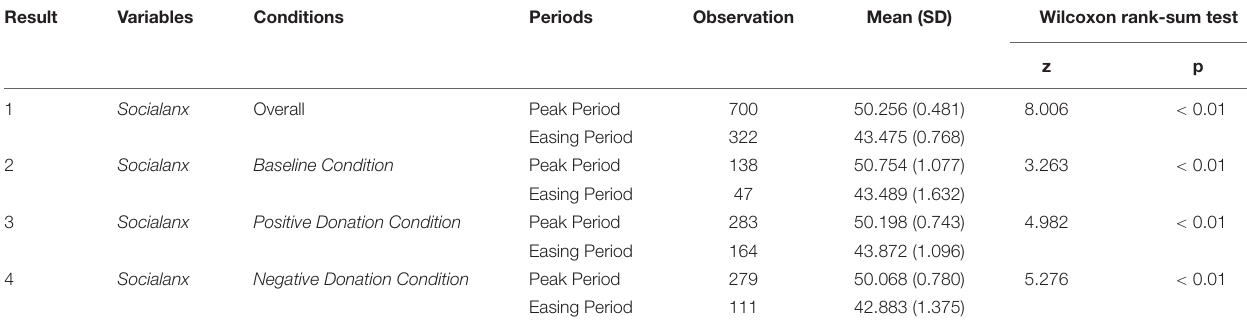
TABLE 6 | Changes in social anxiety along with the abatement of the COVID-19 pandemic.